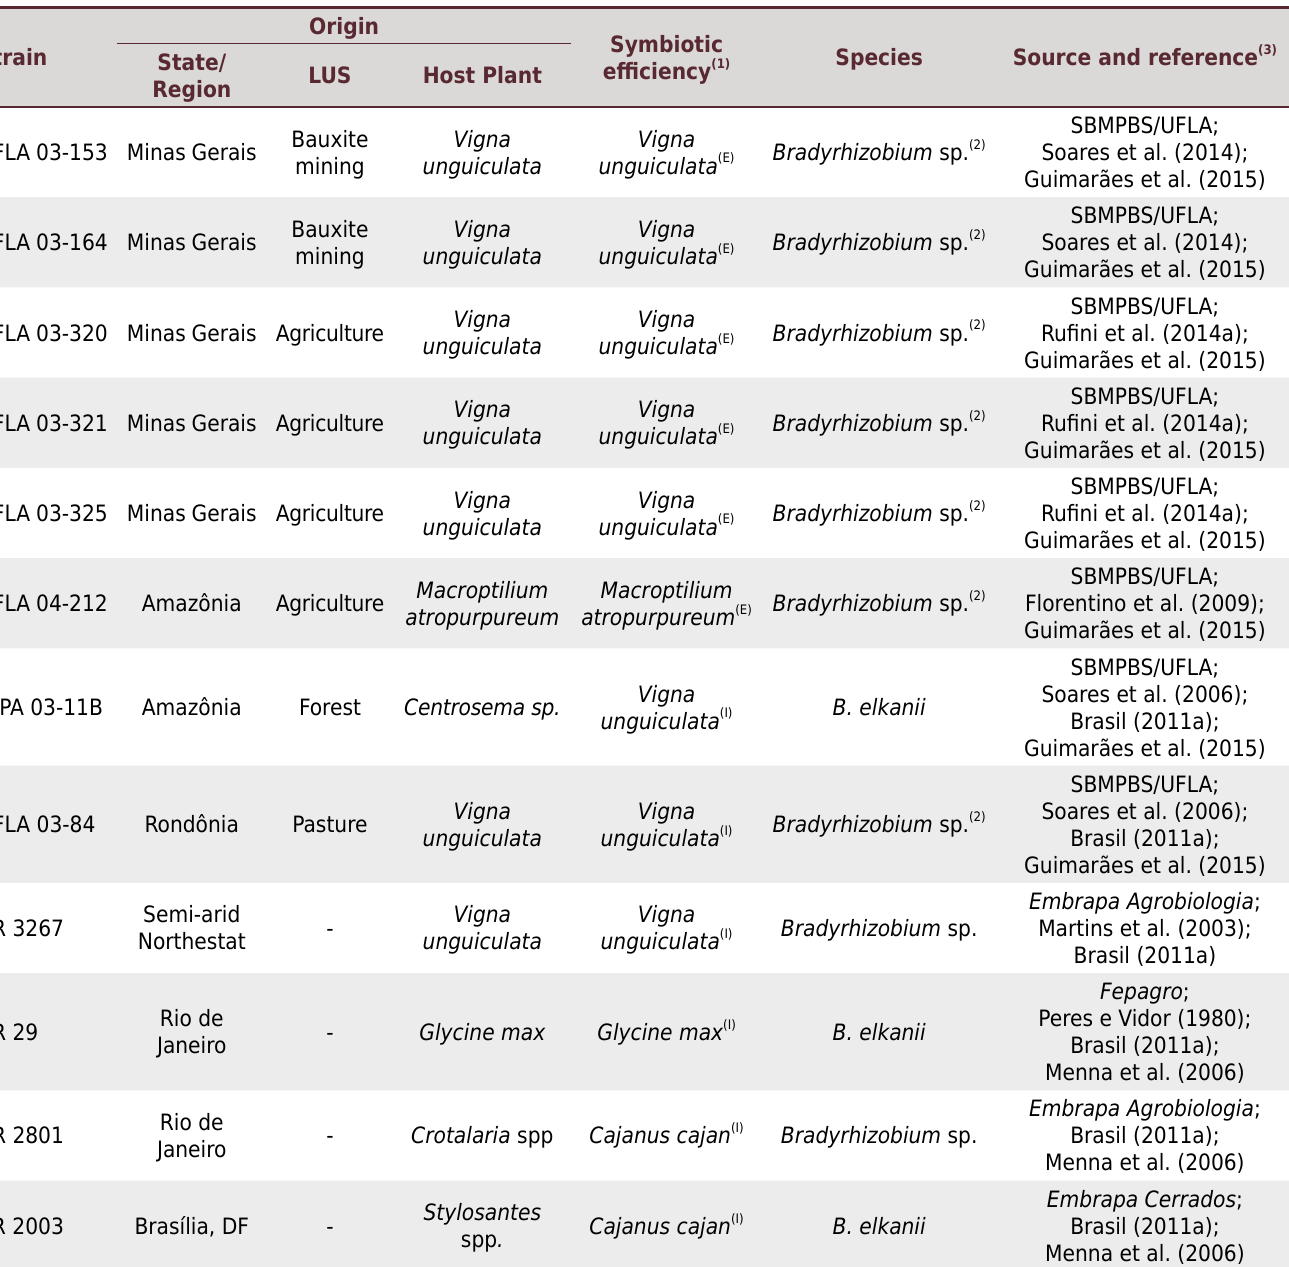
Table 1. Origin and characteristics of Bradyrhizobium strains tested in the experiments Strain